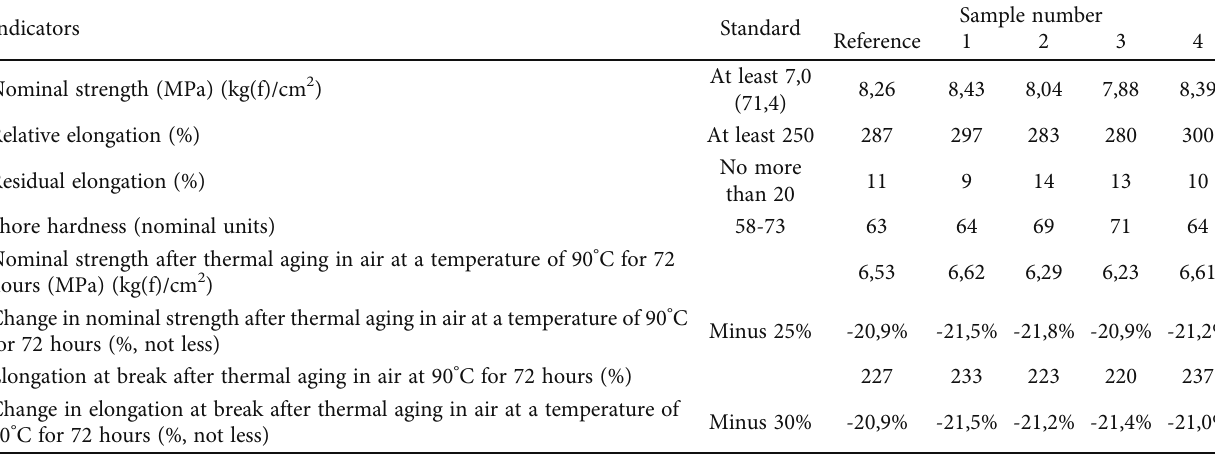
Table 7: The test results of the obtained rubber mixture.